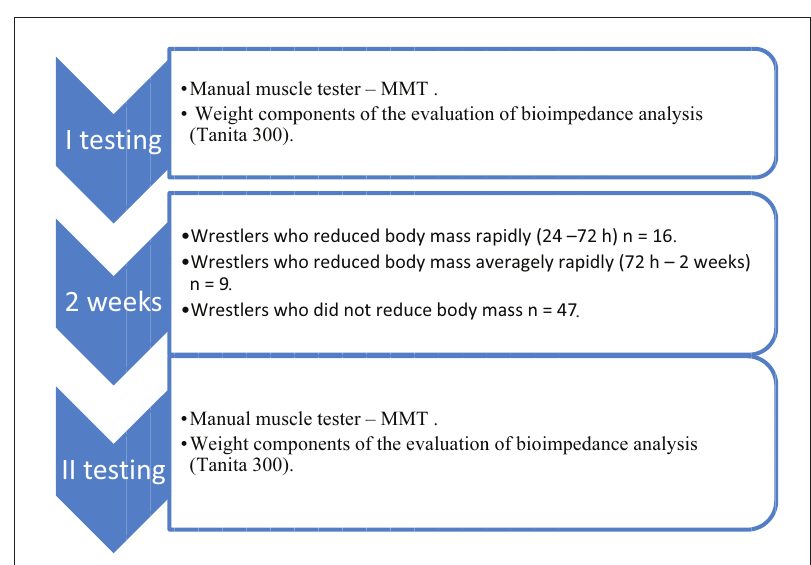
was statistically significantly greater (p < 0.05) than after reducing body mass. The body mass of wrestlers who did not reduce body mass did not change (Figure 2).